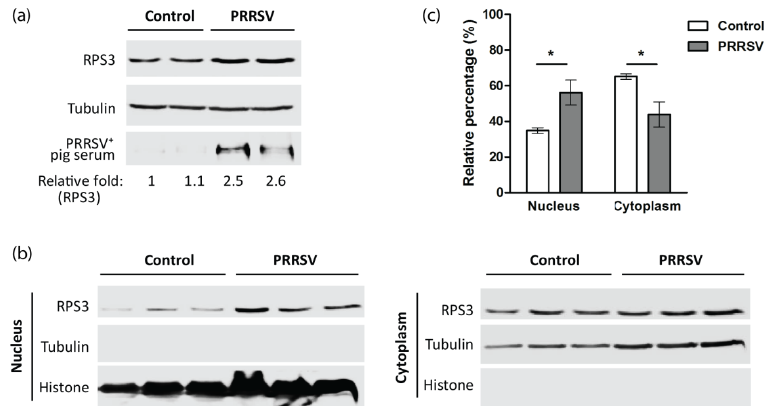
Figure 7. PRRSV infection promotes RPS3 expression and nuclear accumulation in PAMs. ( a ) PRRSV infection increases RPS3 expression. The pulmonary alveolar macrophages (PAMs) from PBS or PRRSV HuN4-inoculated pigs were subjected to IB. ( b ) PRRSV infection facilitates the nuclear accumulation of RPS3. PAMs were subjected to subcellular fractionation, followed by IB of RPS3. The same blot was probed with antibodies against tubulin and histone H2A as controls for loading and fractionation. ( c ) Densitometry analysis of the digital blotting images in ( b ). The RPS3 band intensity of each fraction is shown as the relative percentage of the summed density of both corresponding cytoplasmic and nuclear fractions after normalization with tubulin and histone for cytoplasmic and nuclear fractions, respectively. Significant differences between the control group and the PRRSV- infected group are denoted by “*” for p <